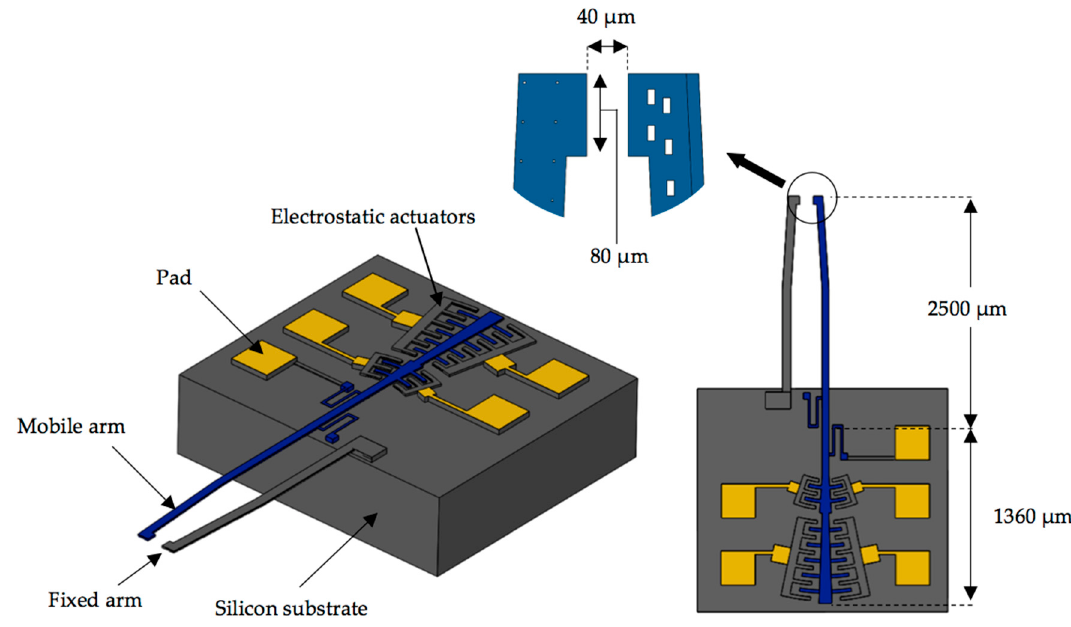
Figure 1. Schematic view of the MEMS microgripper design based on the SUMMiT V fabrication process form Sandia National Laboratories.